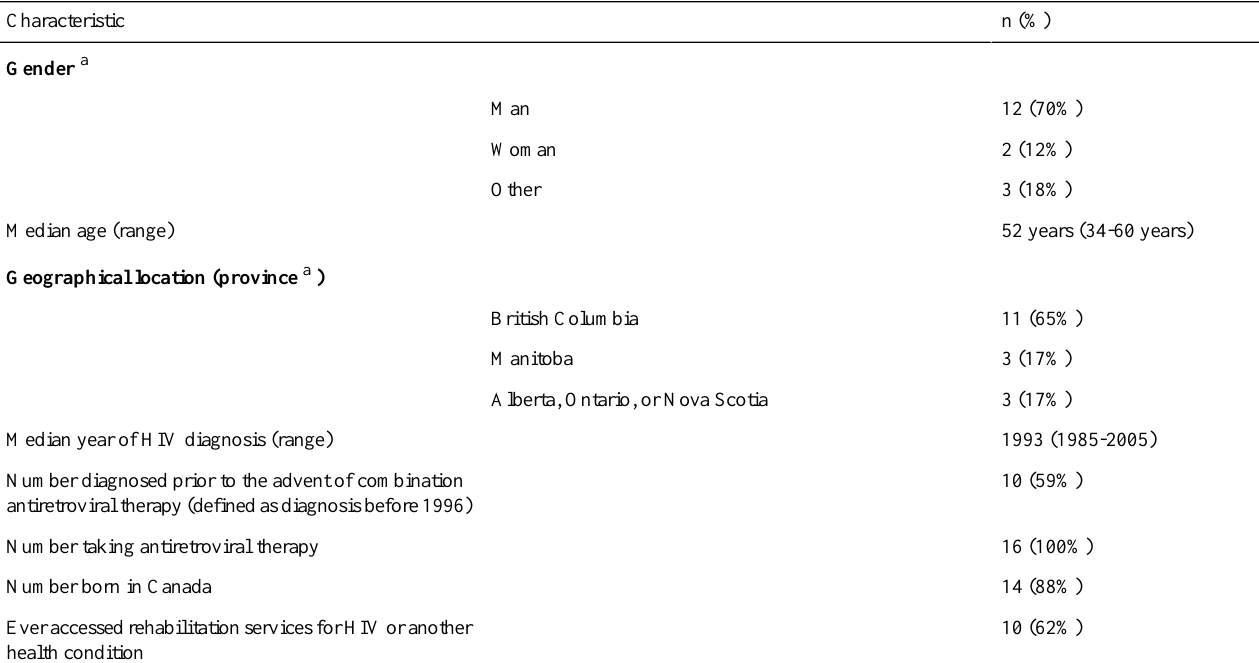
Table 1. Characteristics of interview participants